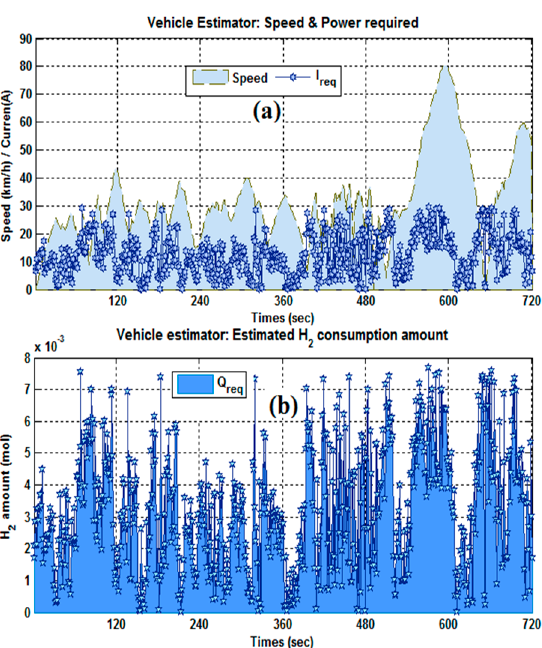
Figure 7. Chosen route test.